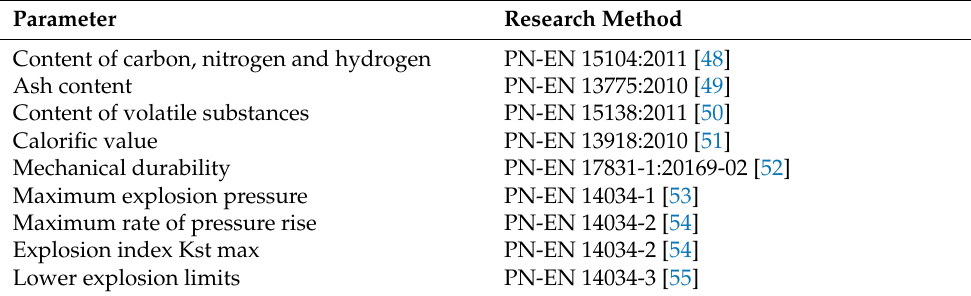
Table 2. Parameters analyzed with research